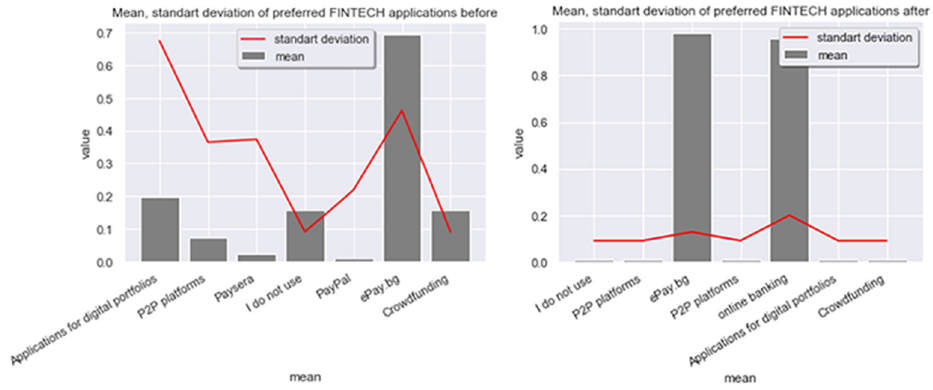
Figure 2. Preferred FINTECH applications before and after the COVID-19 crisis. Source: own re- search.